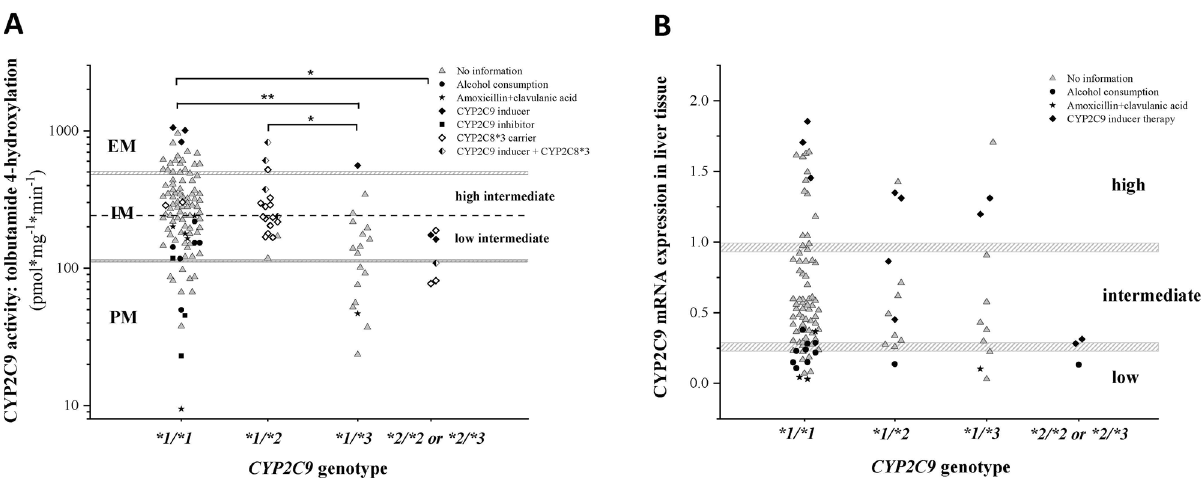
Figure 3. Hepatic CYP2C9 activity (tolbutamide 4 ′ -hydroxylation) ( A ) and CYP2C9 expression ( B ) in subjects carrying various CYP2C9 genotypes. CYP2C8*3 carriers and non-genetic factors (CYP2C9 inducer and inhibitor therapy, amoxicillin + clavulanic acid treatment, chronic alcohol consumption) found in clinical reports of the tissue donors are indicated. The median CYP2C9 activity (dotted line) is for the cutoff value between high and low intermediate metabolizers. PM poor metabolizer, IM intermediate metabolizer, EM extensive metabolizer, low low expression, intermediate intermediate expression, high high expression. * P < 0.05; ** P <